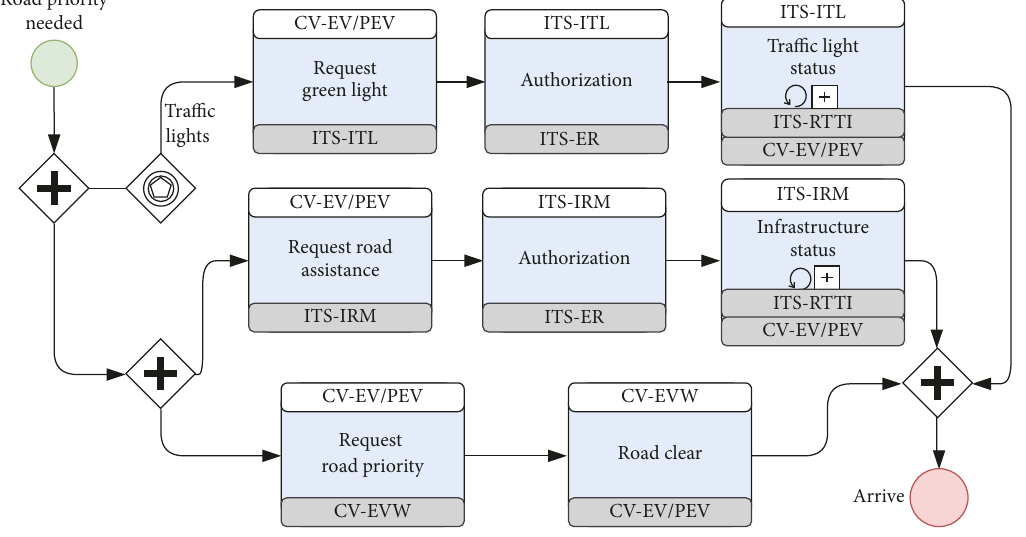
Figure 6: Subchoreography for road priority